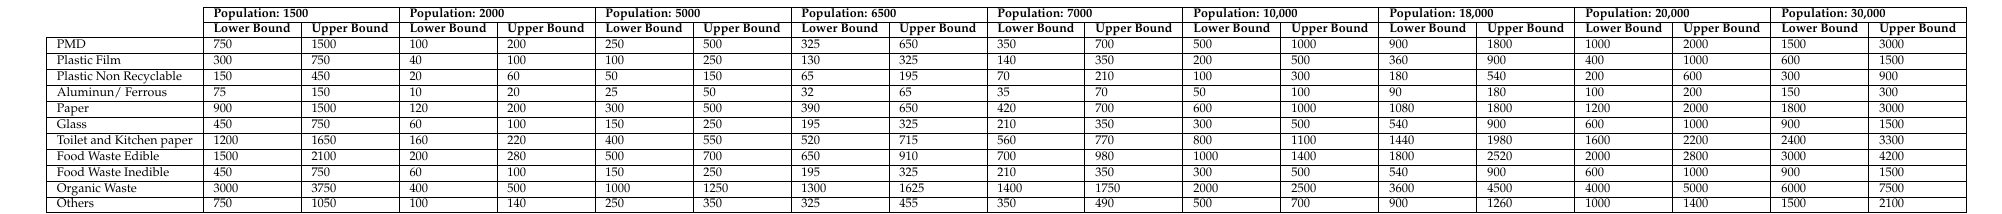
Table 16. The Lower and Upper Bounds for each of the categories for all population options. These values were scaled based on the range from Table